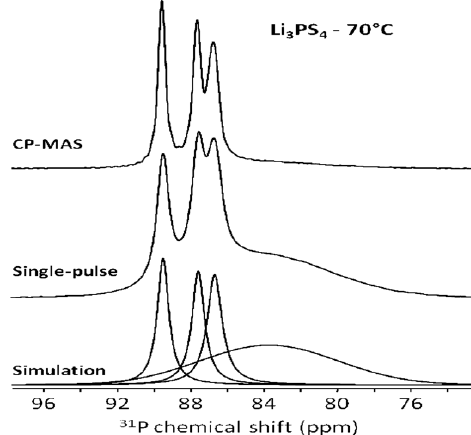
Figure 9. 31 P cross-polarization (CP) and single-pulse spectra for the Li 3 PS 4 glass treated at 70 °C. The broad peak around 84 ppm does not interact with the THF and thus does not appear in the CP spectrum [30] .